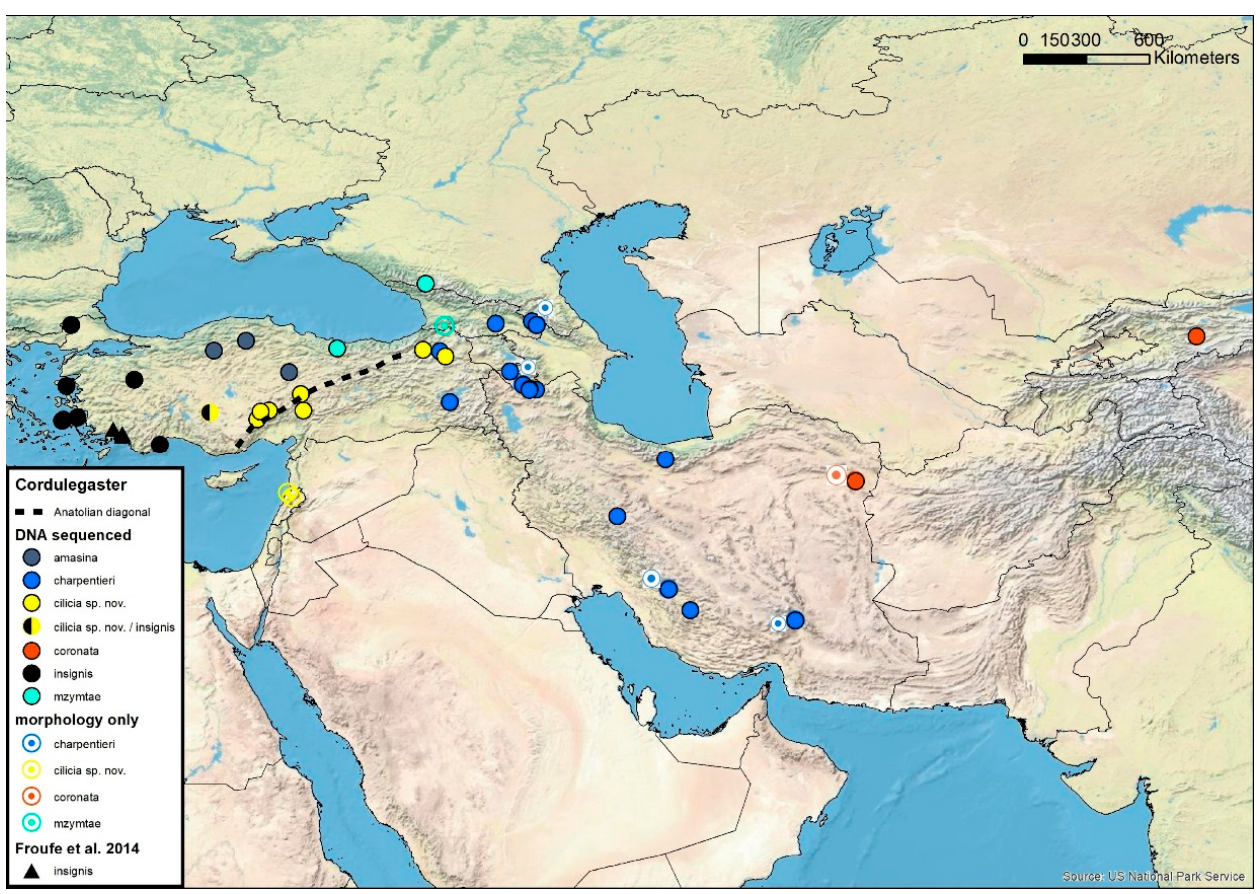
Figure 22. Map of both C. bidentata -complex and C. coronata with species identified in this study relative to the Anatolian Diagonal.